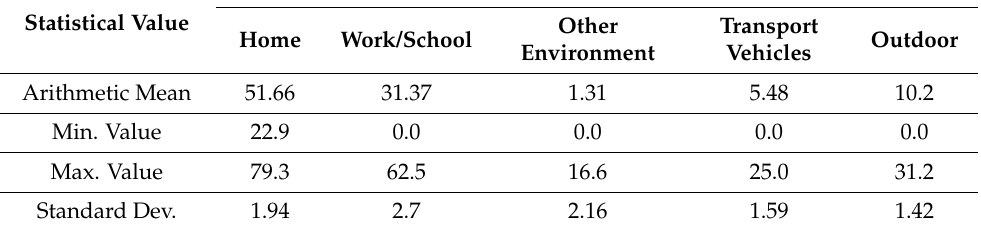
Table 4. Summary of the daily time budget (time distribution) for the entire study population (n = 118 people).